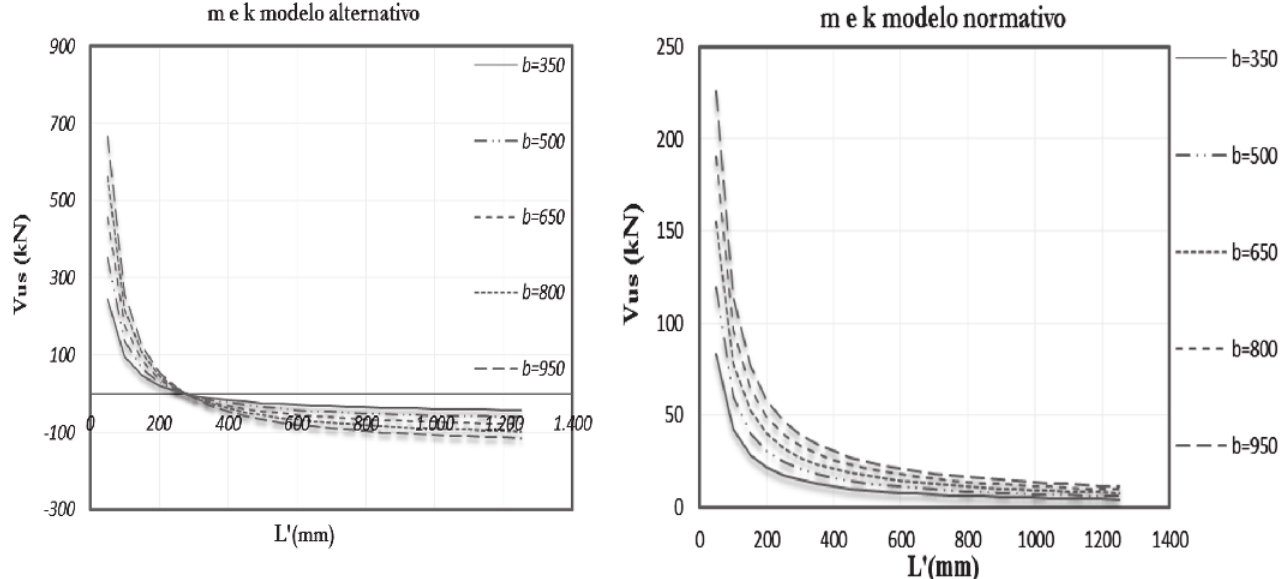
Figura 14 Resistência ao cisalhamento longitudinal ao adotar m e k dos modelos alternativo e normativo variando o vão de cisalhamento das